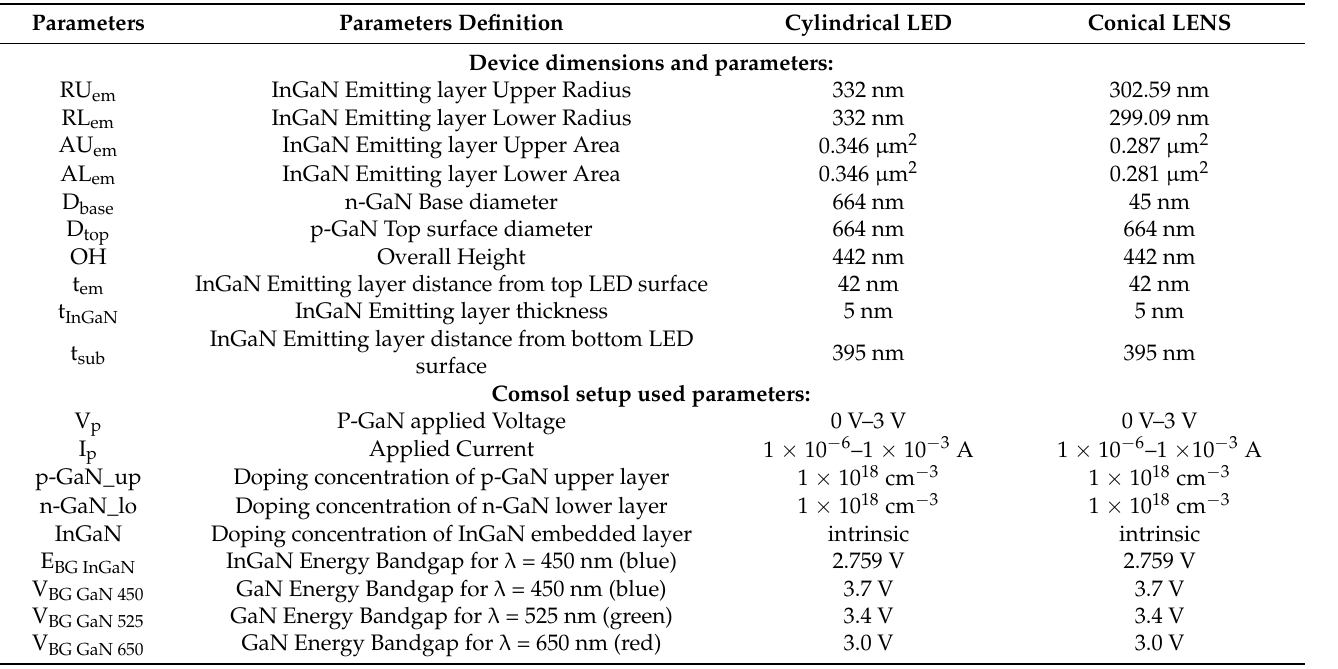
Table 2. Summary of the physical parameters used in geometry study, using